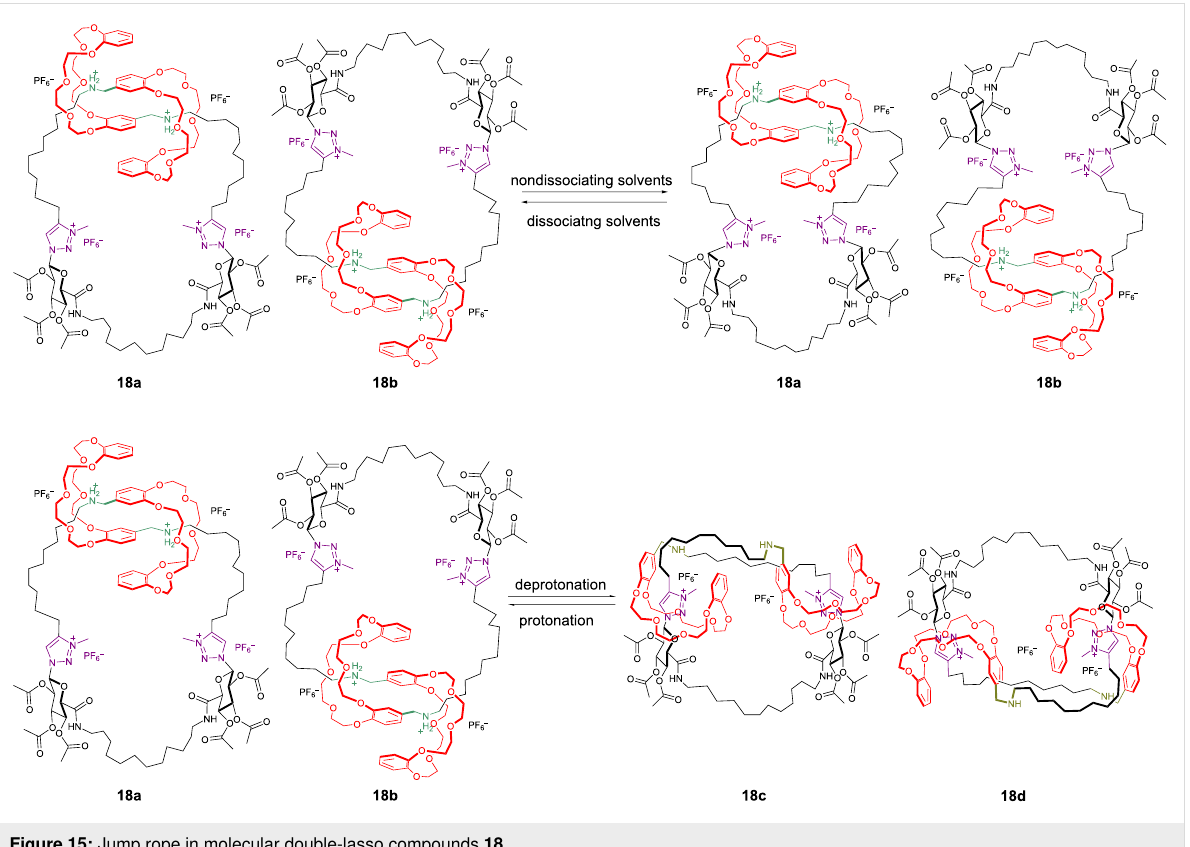
Figure 15: Jump rope in molecular double-lasso compounds 18